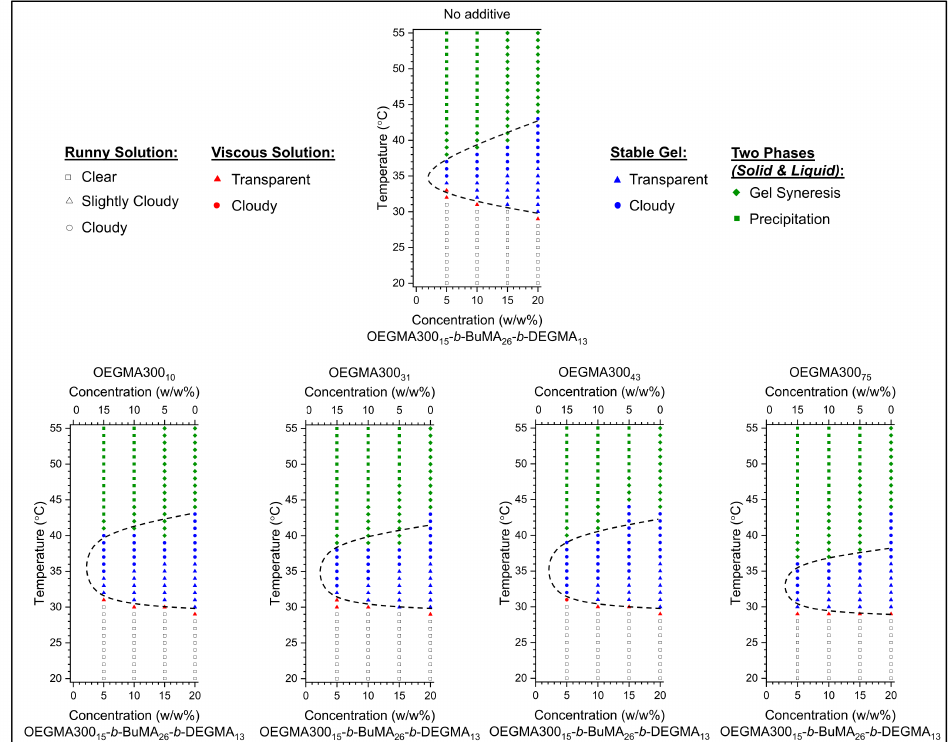
Figure 2. Phase diagrams in phosphate buffered saline (PBS) of mixtures of OEGMA300 15 -b-BuMA 26 - b-DEGMA 13 (P1) without any additives ( top ), or by adding OEGMA300 x homopolymers of various degrees of polymerisation ( bottom ); when x = 10 (P2), x = 31 (P3), x = 43 (P4), and x = 75 (P5) from left to right. The mixtures were prepared at total polymer concentration 20 w/w % and a ratio of P1/OEGMA300 x equal to 1:3, 1:1, and 3:1. The following transitions are reported: (a) runny solution in white, (b) viscous solution in red, (c) stable gel in blue), and (d) phase separation in green. The gelation area is approximately indicated by a black dashed